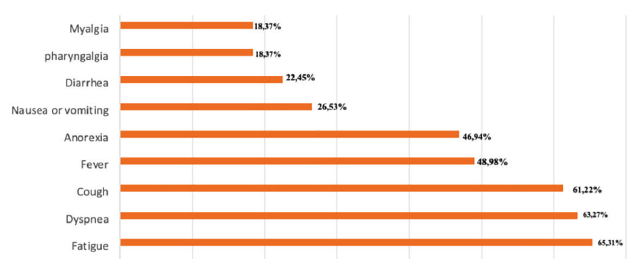
Figure 1 - Symptoms in patients with diabetes mellitus